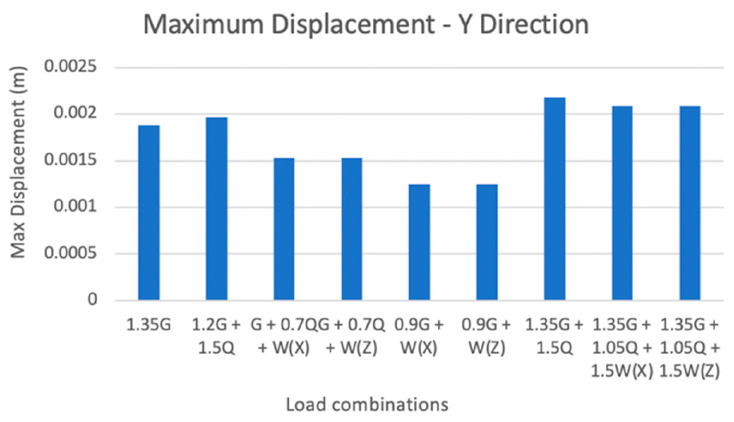
Figure 5. Maximum vertical displacement of DFF for each load combination.